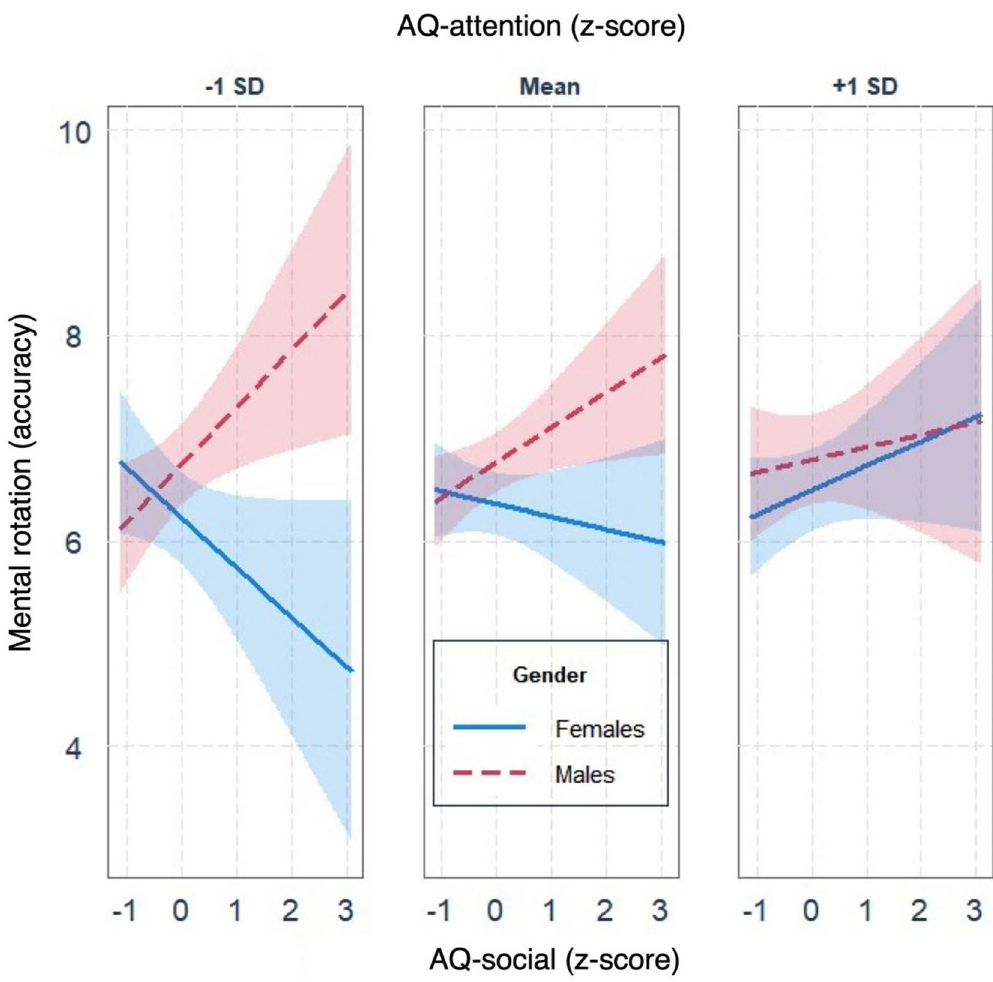
Figure 2. The effect of social traits on mental rotation performance moderated by both sex and non-social